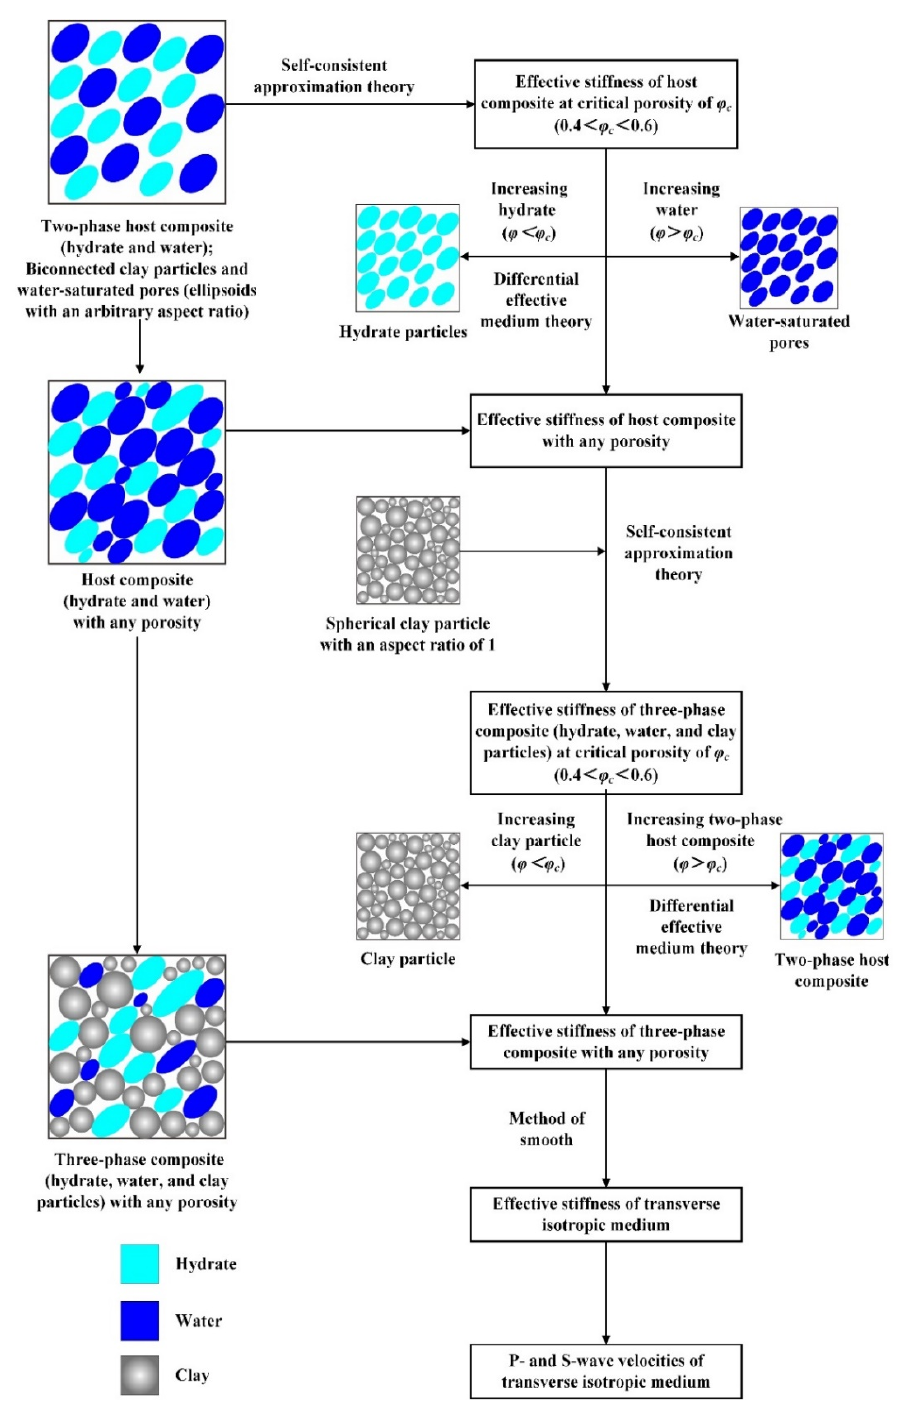
Figure 8. Workflow of the effective medium anisotropic model.